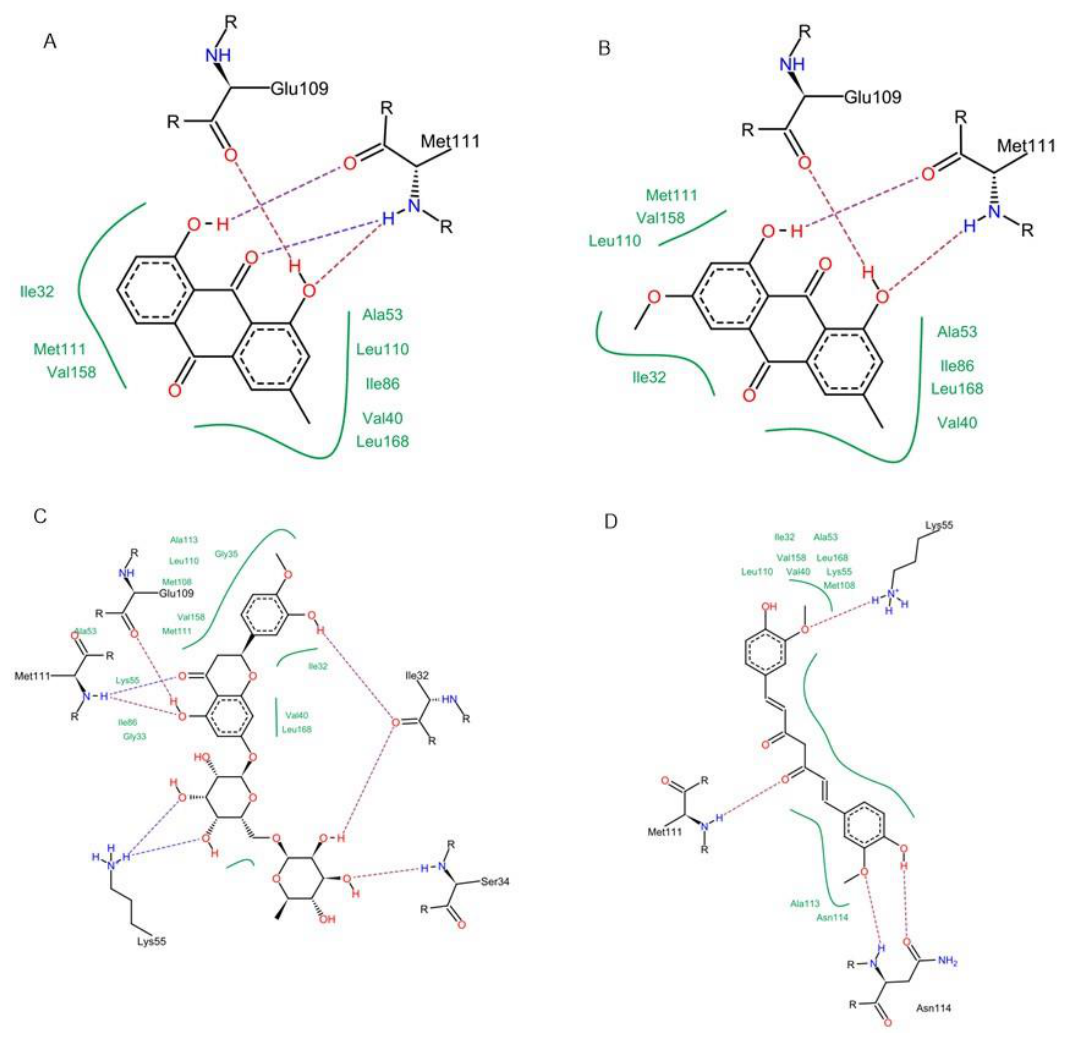
Figure 9. 2D Protein ligand binding diagram of chrysophanol ( A ), physcion ( B ), hesperidin ( C ) and curcumin ( D ) with JNK MAPK (PDB ID: 1UKI).